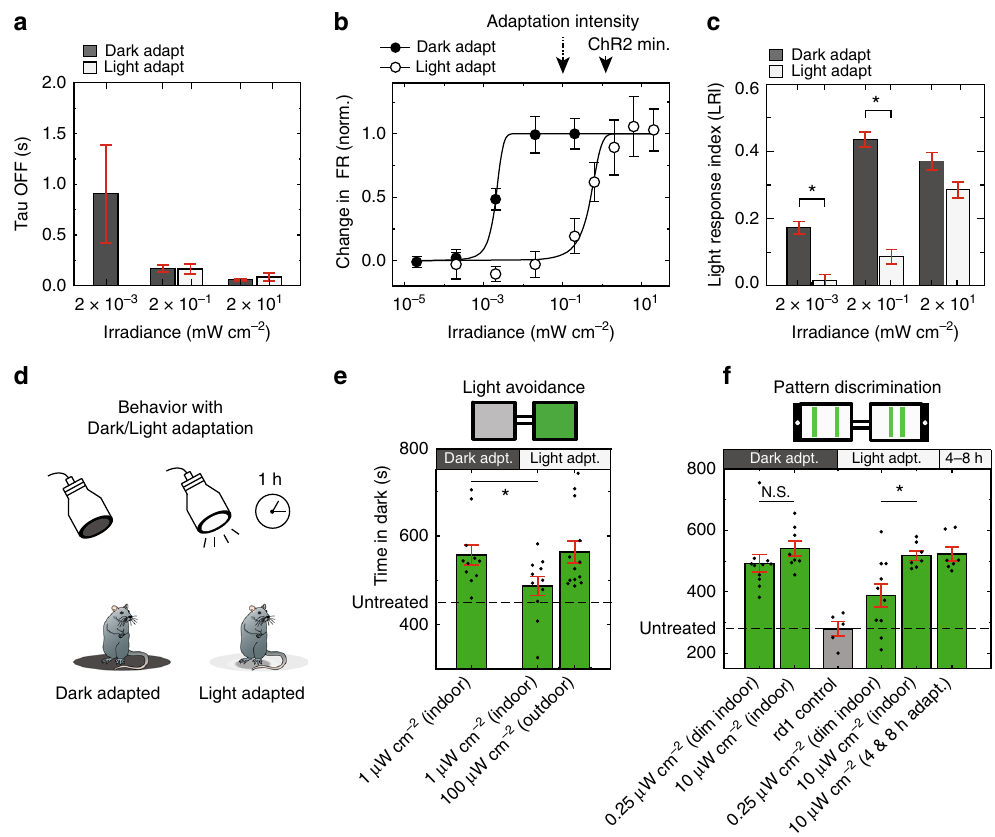
Fig. 4 Light adaptation in RGC activity and visually guided behavior by MW-opsin. a – c MEA recordings in isolated retina of RGC light response mediated by MW-opsin in RGCs of rd1 mouse retina show sensitivity difference with retina adapted to dark versus light. a Light response decay (Tau OFF) as a function of fl ash intensity in dark versus light adapted condition ( N = 3 retinas, n c = 88 channels). b Example intensity-response curve for representative retina fi rst dark adapted ( fi lled symbols) then light adapted (open symbols) ( n = 56 cells). White light adaptation. ChR2 minimum value from Bi et al. 13 and Sengupta et al. 18 . c Average (error bars are SEM) normalized Light response Index (LRI) at 3 fl ash intensities in same retina, fi rst dark adapted and then light adapted ( N = 3 retinas, n c = 88 channels). d – f Behavior shows light adaptation in visually guided tasks. d Schematic of adaptation to dark or light prior to testing of innate avoidance behavior or learned pattern discrimination behavior. e Proportion of time spent in the dark compartment (proportion of avoidance) under 100 μ W cm − 2 (bright light) or 1 μ W cm − 2 (dim indoor light) following 1 h. of adaptation to dark ( N = 11 mice) or adaptation to light (white light; 1 mW cm − 2 /535 nm spectral component; ~50 μ W cm − 2 ; N = 11,13 mice). f Learned pattern discrimination of parallel bars spaced at distances of 1 versus 6 cm displayed at low (0.25 μ W cm − 2 ) or indoor (10 μ W cm − 2 ) light levels following 1 h. of adaptation to dark ( N = 11 and 8 mice for each display) or light (white light; 1 mW cm − 2 /535 nm spectral component; 50 μ W cm − 2 ; N = 10 and 7 mice for each display). Performance was also reported in cohorts experiencing 4 and 8 h. of light adaptation ( N = 7 mice). Dotted line denotes average performance of untreated rd1 control mice and performance (gray N = 5 mice) reproduced from Fig. 3h for reference and comparison. Wavelength: λ = 535 nm. N = # of animals, n = # of retina, n c = number of channels. Cells are identi fi ed as sorted units. Values are mean + SEM. Statistical signi fi cance assessed using Mann-Whitney U test (* p < 0.01). Student ’ s two-tailed t -test with Bonferroni correction: * p <